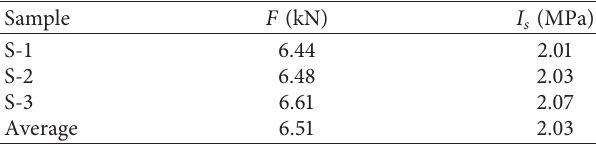
Table 1: Point load test results under static load.